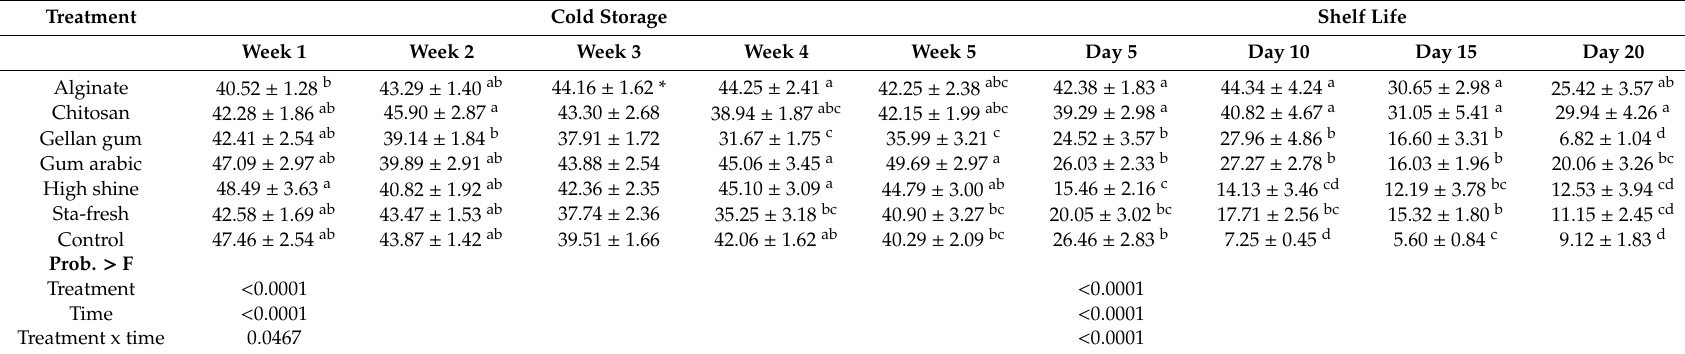
Table 3. Flesh firmness (N) in plums (‘African Delight ™ ’) during a simulated shipping period (cold storage; − 0.5 ± 2 ◦ C and 90 ± 5% RH for 5 weeks) and shelf life (20 ± 2 ◦ C and 75 ± 5% RH for 20